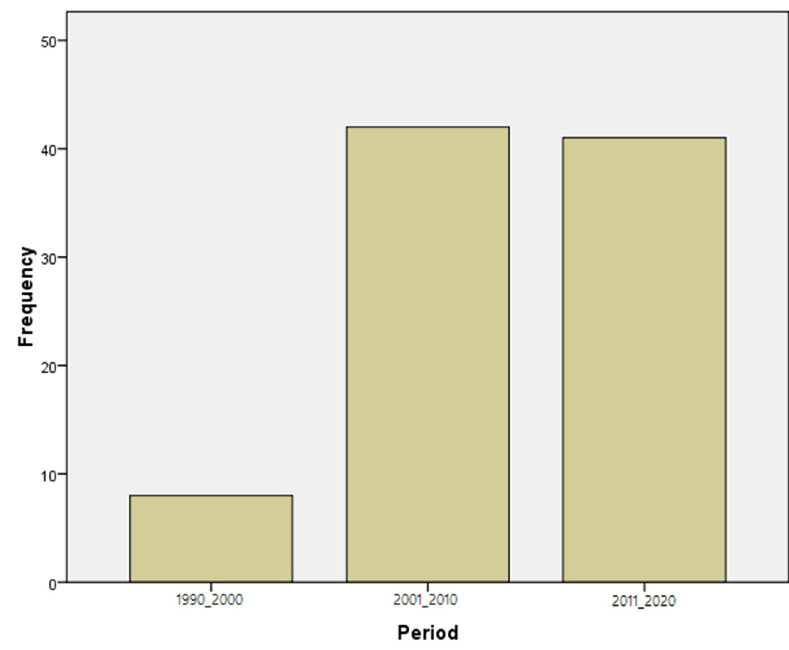
Figure 1. SLR final paper collection from different periods.